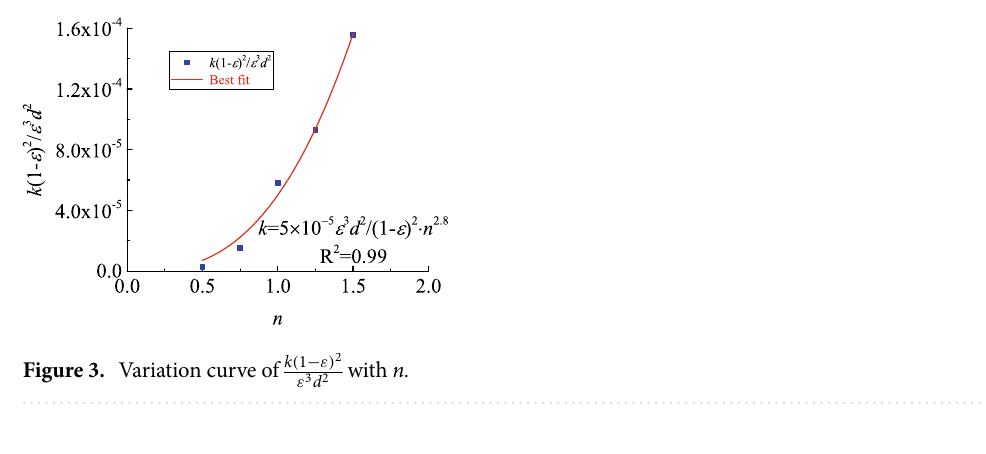
Figure 3. Variation curve of